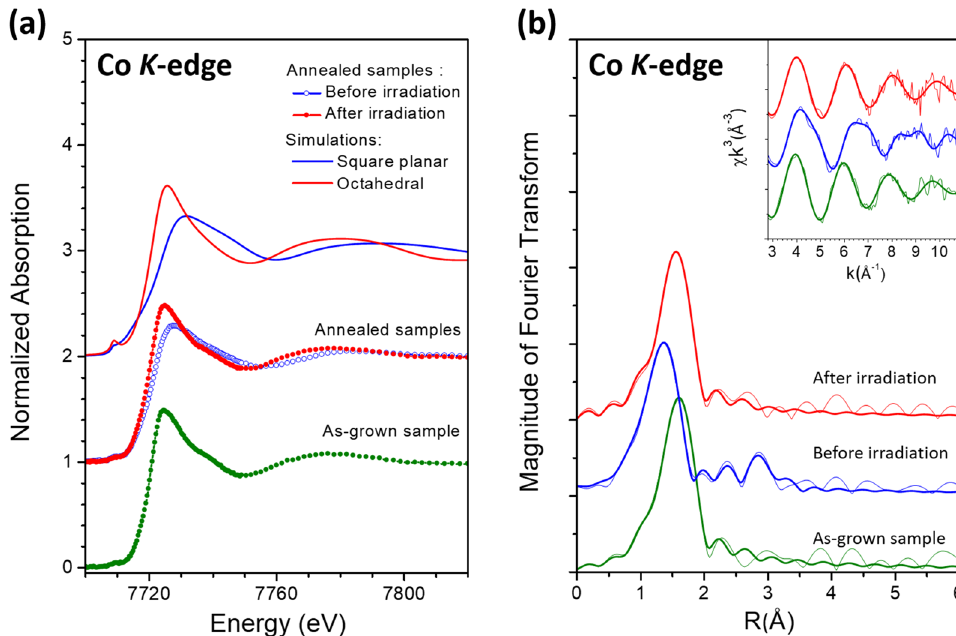
Figure 2. ( a ) Theoretical and experimental Co K-edge XANES curves for (Y, Co)-codoped CeO 2 samples. ( b ) Co K-edge EXAFS data for (Y, Co)-codoped CeO 2 samples. Fine lines: experimental; Coarse lines: curve fitting. Curves have been shifted vertically for the sake of clarity.